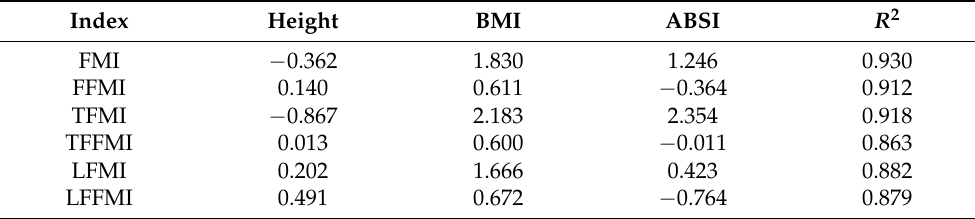
Table 2. Regression coefficients for body composition indices from DEXA versus simple anthropo- metric indices.